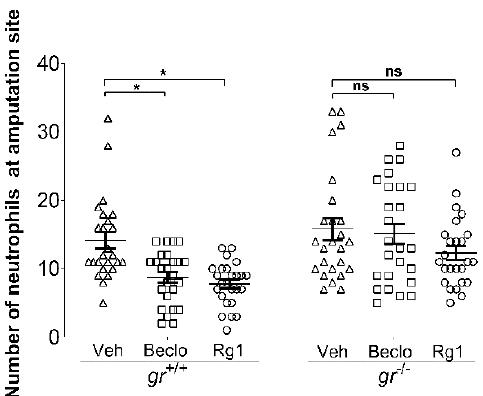
Figure 2. Glucocorticoid receptor (GR)-dependency of the anti-inflammatory effects of Rg1 and beclomethasone. Quantification of neutrophil migration towards the amputated site in the tail fin at 3 dpf in Gr mutant ( gr − / − ) and wild type ( gr +/+ ) larvae, after treatment with vehicle, beclomethasone (Beclo), or Rg1. The graphs show data from an experiment with 25 larvae per group (each indicated as individual data points), representative of three experimental repeats. ns—not significant. * p < 0.05.